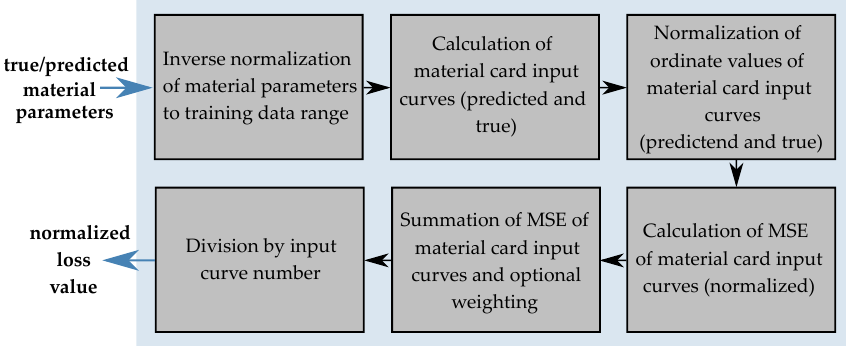
Figure 10. Process of the custom loss function calculation.